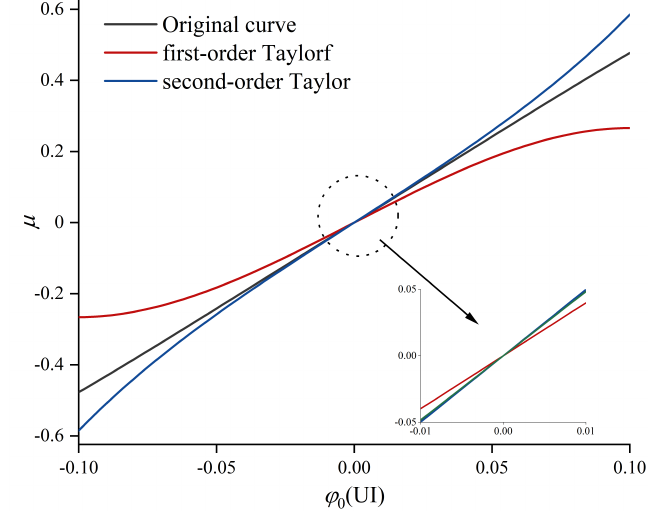
Figure 14. Comparison of average output voltage in linear region. Combining the numerical analysis and images, select (7) as an approximate